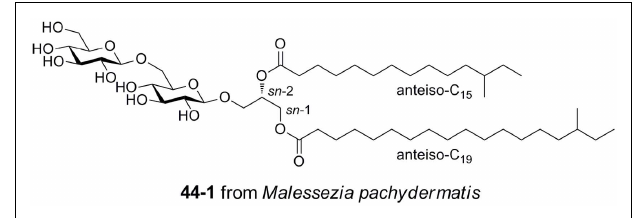
FIGURE 6 | Gentiobiosyl diacylglycerides from the fungus Malessezia pachydermatis , ligands for mouse Mincle